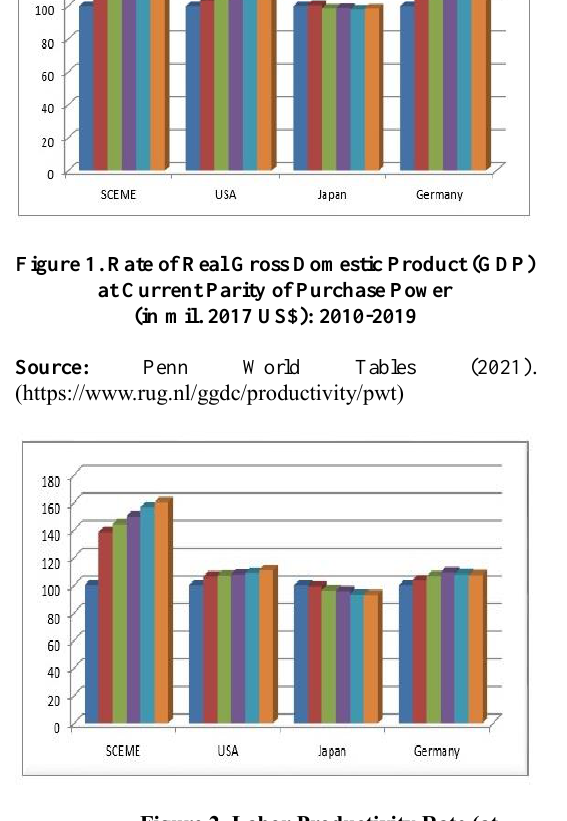
Figure 2. Labor Productivity Rate (at